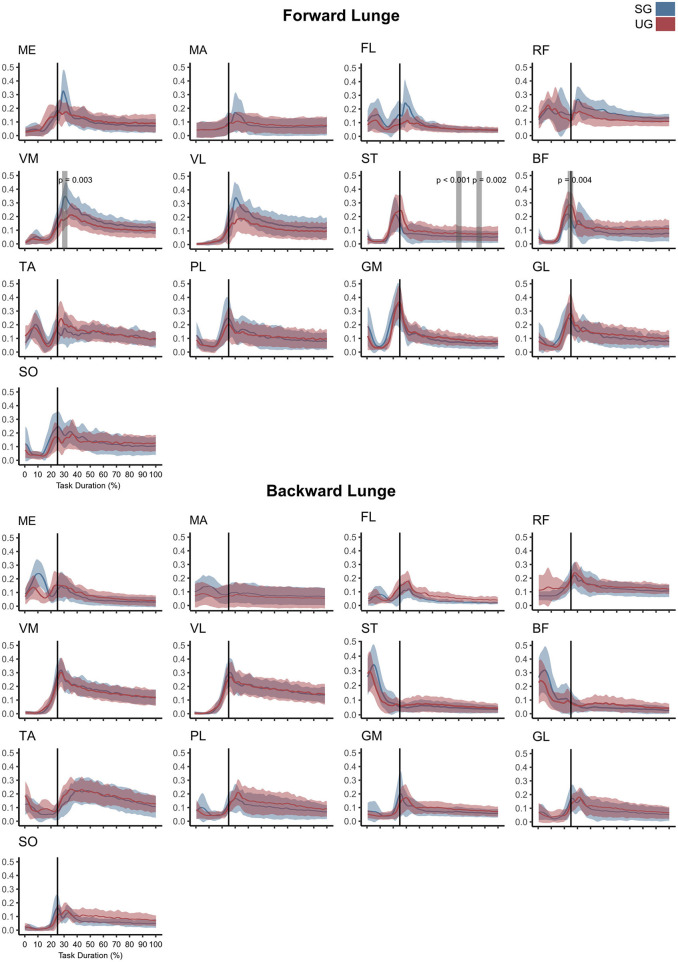
Mean values and standard deviation bands for the EMG activities for a forward and backward lunge from lift-off until steady state on stable (SG—blue) and unstable ground condition (UG—red) normalized to the maximum activity between trials. Panels are presented in a time normalized base, vertical lines represent touchdown. Gray bands denote periods of significant difference estimated with a Bonferroni corrected statistical parametrical mapping difference estimator. Muscles: Gluteus Medius (ME), Gluteus Maximus (MA), Tensor Fascia Latae (FL), Rectus Femoris (RF), Vastus Medialis (VM), Vastus Lateralis (VL), Semitendinosus (ST), Biceps Femoris (long head, BF), Tibialis Anterior (TA), Peroneus Longus (PL), Gastrocnemius Medialis (GM), Gastrocnemius Lateralis (GL), and Soleus (SO).